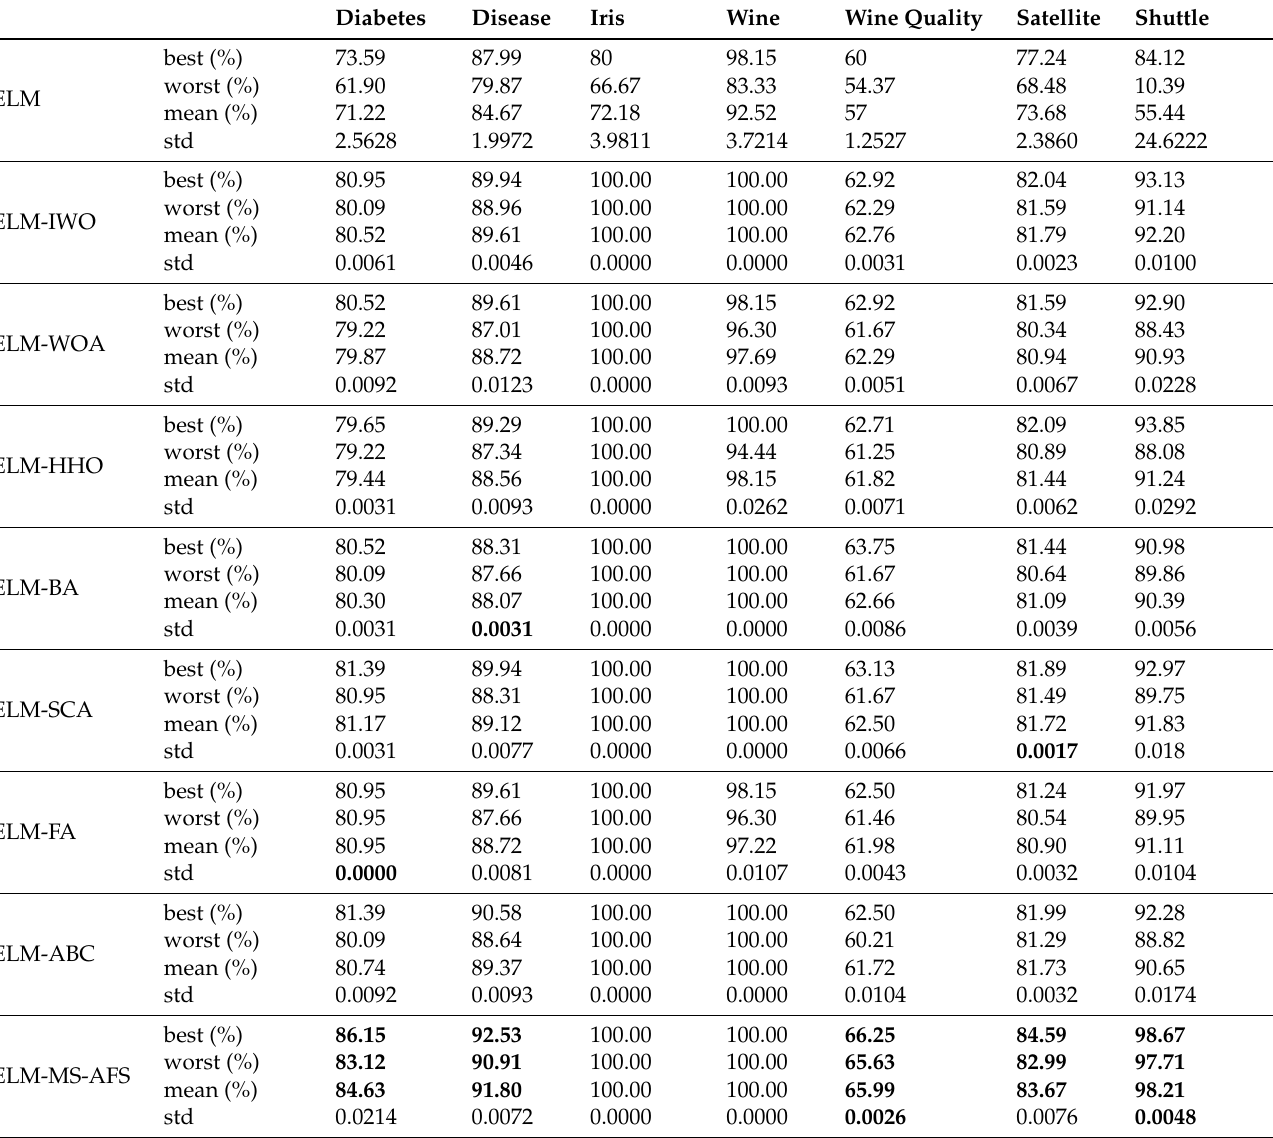
Table 2. Accuracy comparative analysis for simulations with 30